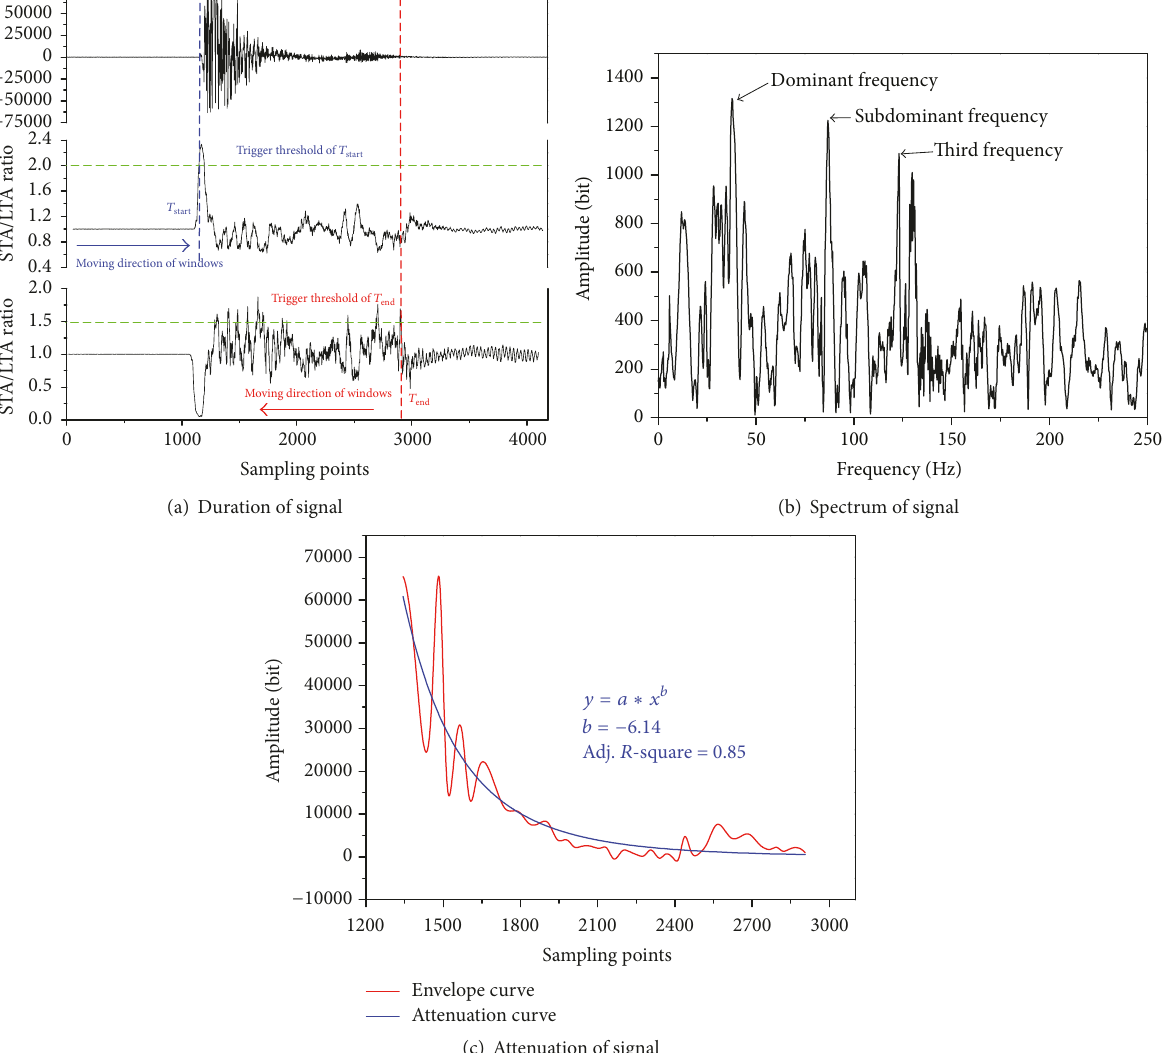
Figure 11: Signal characteristics of sensor S7 for the destructive mining MS